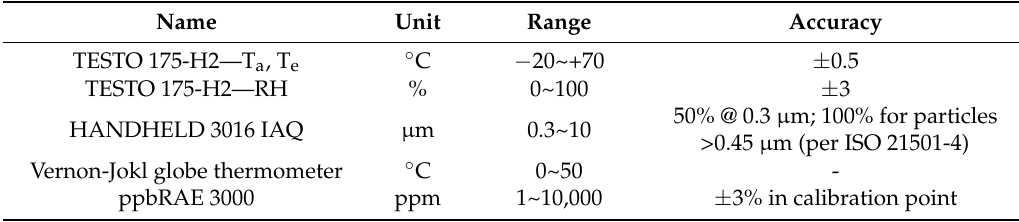
Table 1. Basic information about measuring